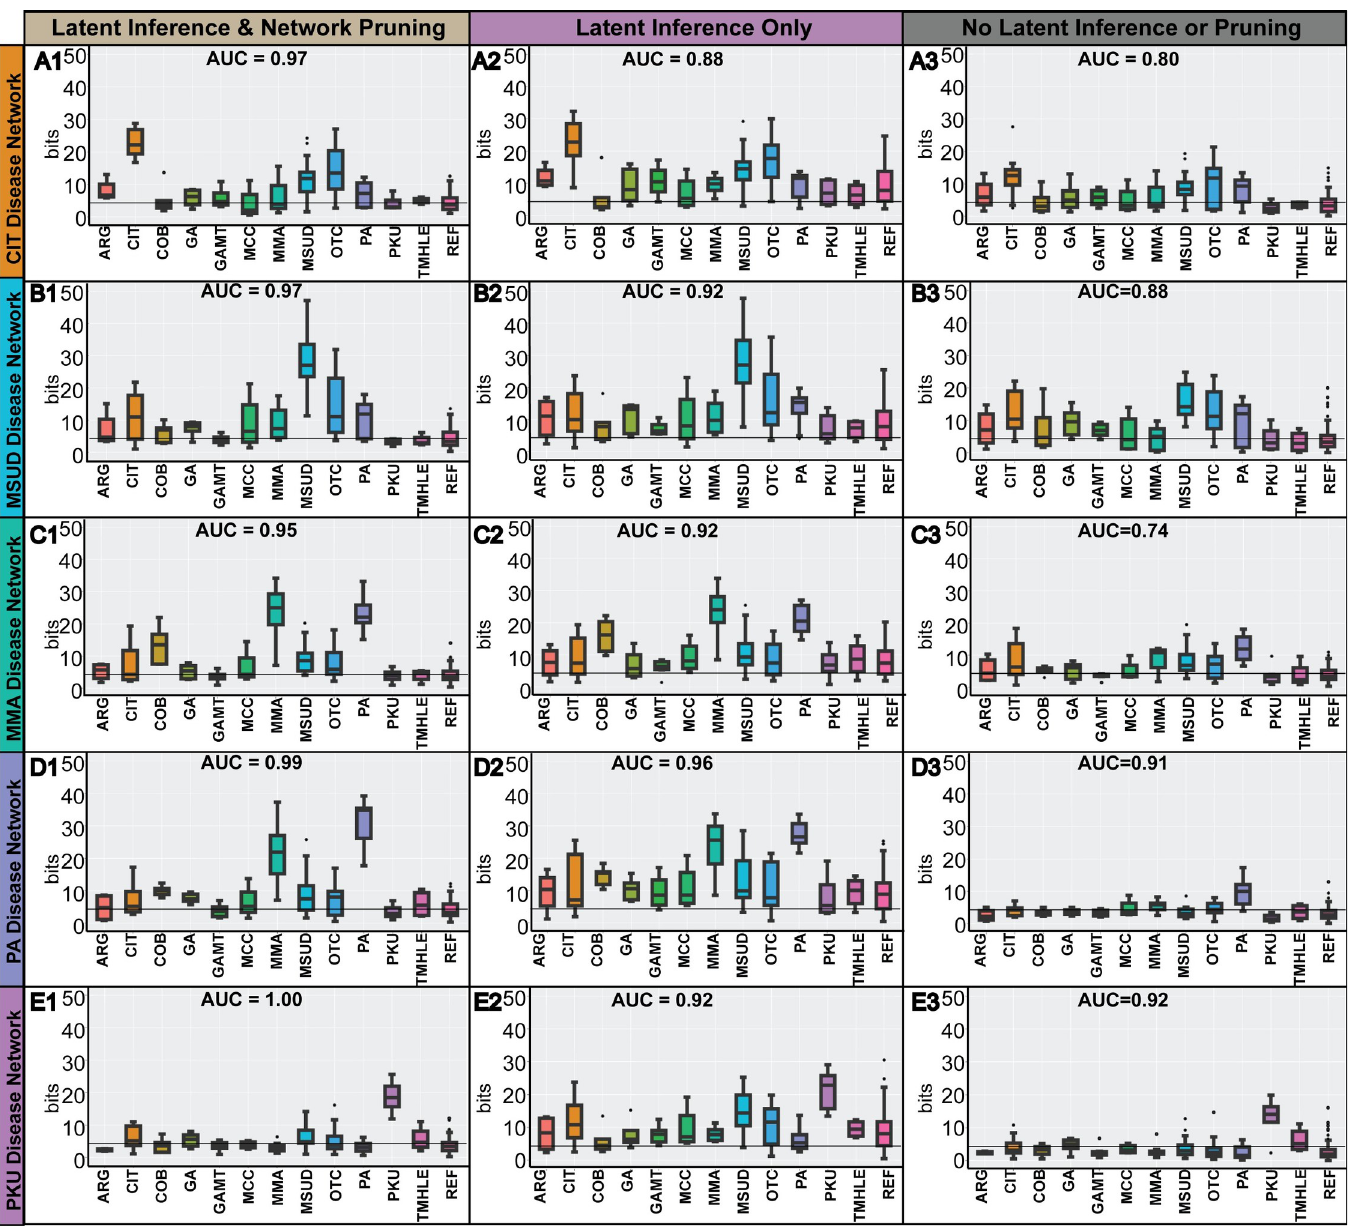
Fig 3. Significance of multi-metabolite perturbation signatures assigned by CTD. Using either i) discriminative latent structure inference with network pruning, ii) discriminative latent structure inference without network pruning, or iii) neither discriminative latent structure inference or network pruning during network learning, patients were scored using CTD and leave-one out cross validation against five different disease-specific network contexts: (A) citrullinemia, (B) maple syrup urine disease, (C) methylmalonic aciduria, (D) propionic aciduria, and (E) phenylketonuria. When using both discriminative latent structure inference and network pruning (column 1), disease patients showed strong significance when interpreted against the correct disease-specific network and little to no significance when interpreted with incorrect disease-specific networks. Without network pruning (column 2), the vast majority of patients across all diagnostic categories showed significantly connected submodules. Thus, network pruning improves network specificity. The added effect of removing discriminative latent structure inference (column 3) from network learning is lower sensitivity, as the disease patients show weaker signal in the correct disease-specific network context. The grey horizontal line is drawn at ~4.32 bits (i.e., FDR corrected p- value of 0.05). All scores are reported in bits, which are negative logarithms of p-values (see Materials and Methods